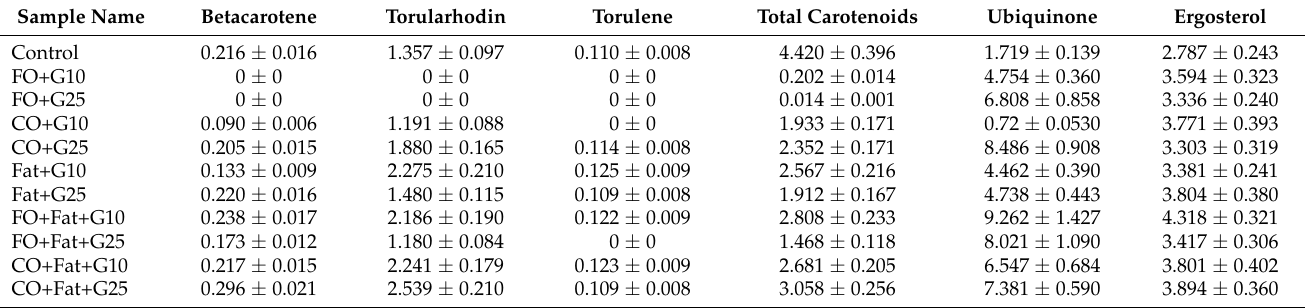
Table 4. HPLC analysis of Phase I screening cultivations Rhodotorula kratochvilovae cultivated on a combination of waste lipids and glycerol. Productions are listed in mg/g of cell dry weight.